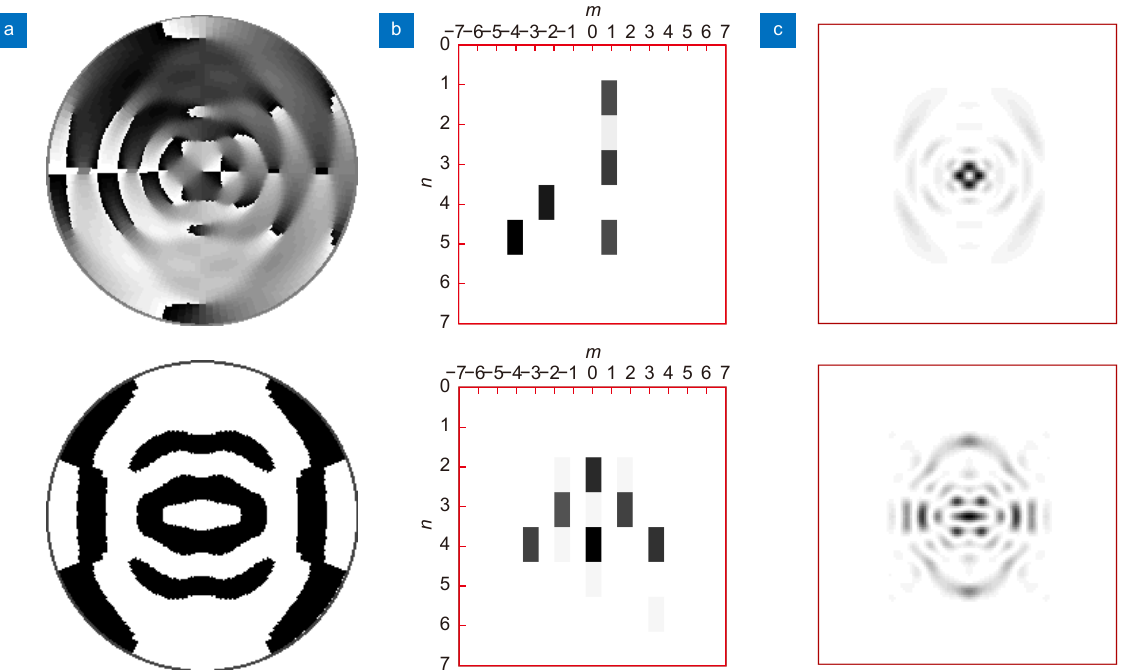
Fig. 17 | Multimode Laguerre-Gauss beams. ( a ) The DOE phase. ( b ) The squared modulus of the coefficients in the superposition. ( c ) The in- tensity distributions in the focal plane for 5-modes beam (the upper row) and the 6-modes beam (the bottom row). Figure reproduced from ref. 154 , American Institute of Physics.